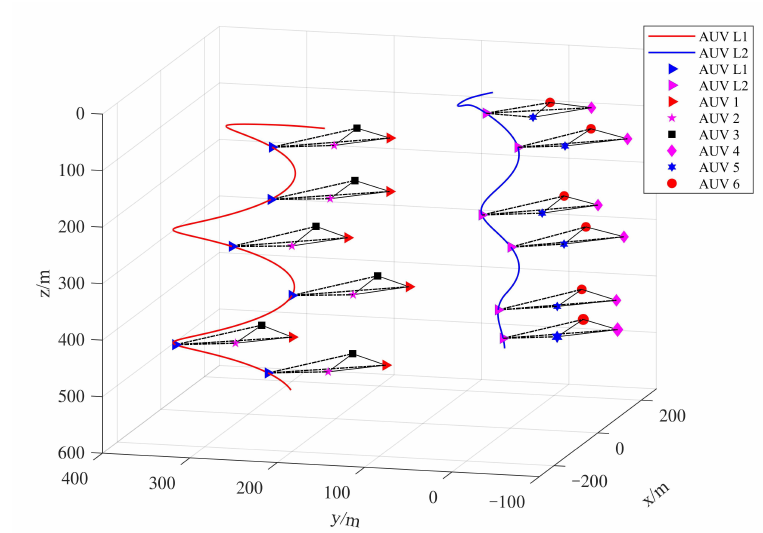
Figure 9. Position trajectories of a multiple stochastic AUV system.